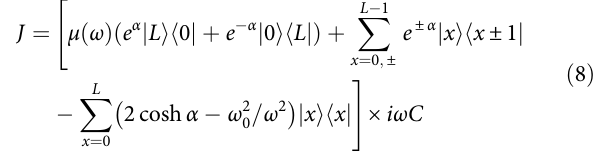
ψ R α th node. To isolate a particular λ 0 th eigenmode, λ values at the we tune the circuit until ϵ λ 0 (cid:4) 0, either by adjusting its variable components or by varying the AC frequency ω 46 . V α is then